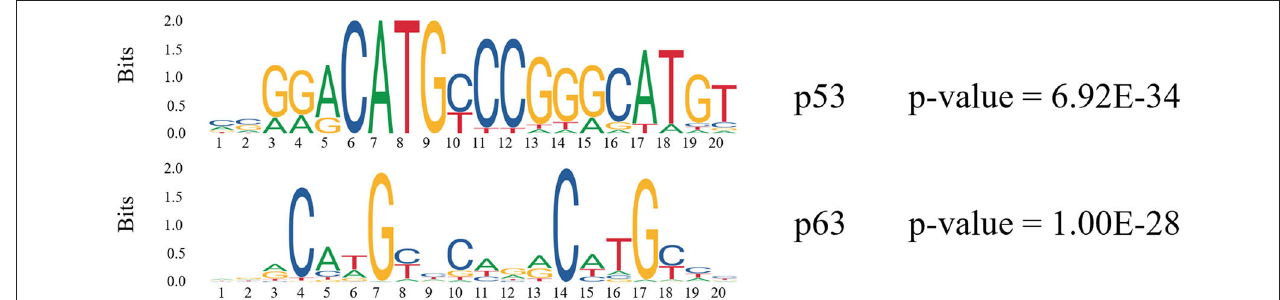
FIGURE 4 | Motif analysis on p53-bound enhancer. The consensus logo represents the degree of conservation of each position using the height of the consensus character at that